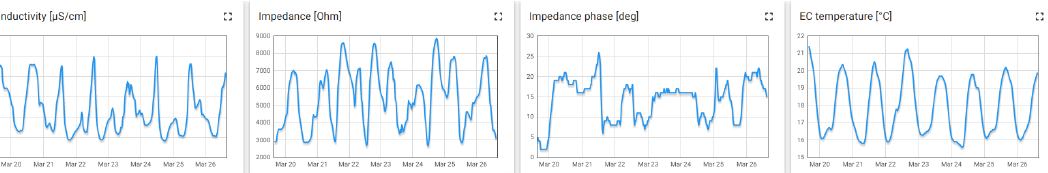
Figure 9. Dashboard showing sensor values for tomato crop (one-month data with message interval of 5 min).